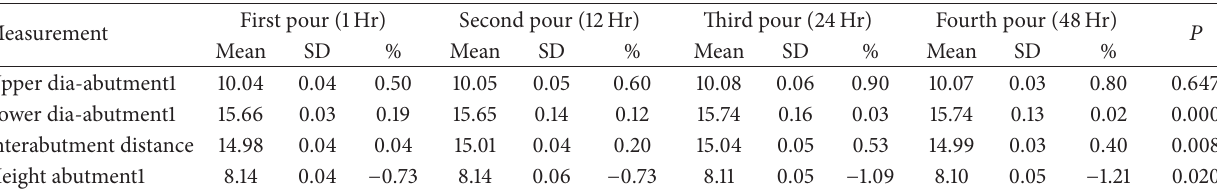
Table 2: The mean measurement values of stone dies, standard errors, and percentage of errors from master cast from heavy-light body single mix impression technique.